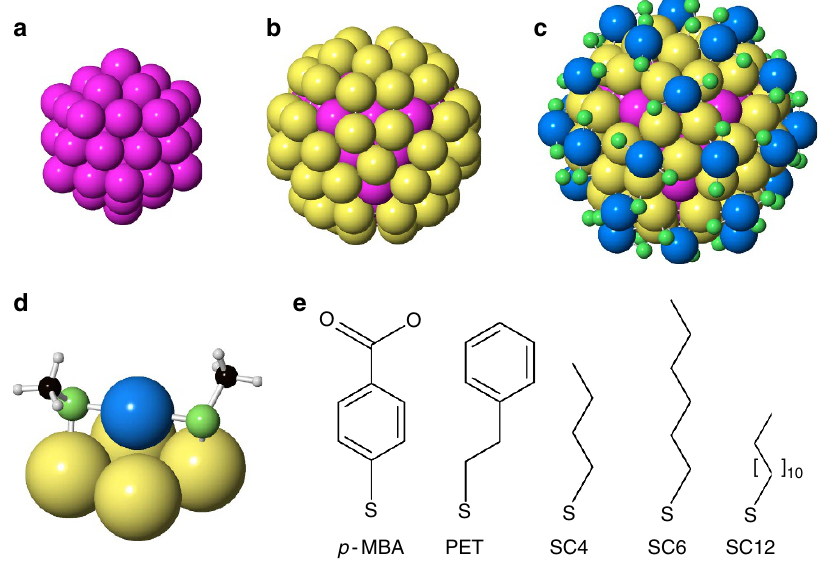
Figure 1 | Structure of the icosahedral Au 144 (SR) 60 cluster. ( a ) Fifty-four atom gold core consisting of two Mackay icosahedron shells. ( b ) The icosahedral gold core (pink) is covered by 60 gold atoms (yellow) making up the grand core. ( c ) Total structure, where the grand core is covered in ‘staples’—green atoms represent sulfur, whereas blue atoms represent gold in the staple structure. The organic carbon chains have been left out for clarity. ( d ) Illustration of staple structure on gold surface. ( e ) Thiolate ligands used in the study. From left: p -MBA, PET, SC4, SC6 and